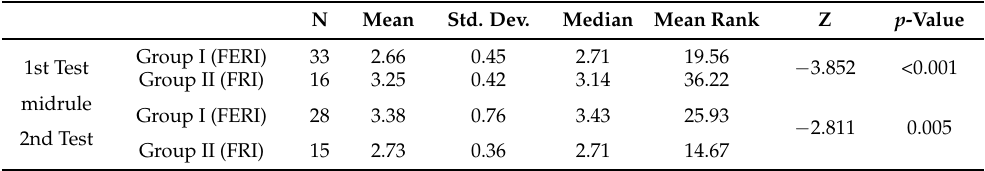
Table 8. Feedbackon simplicity of AGs (Mann–Whitney test). N Mean Std.